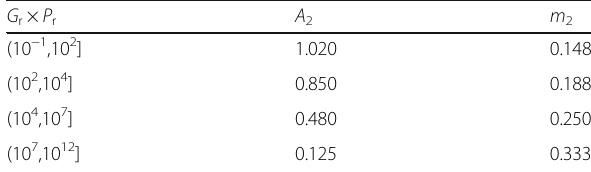
Table 2 The value of parameters A 2 and m